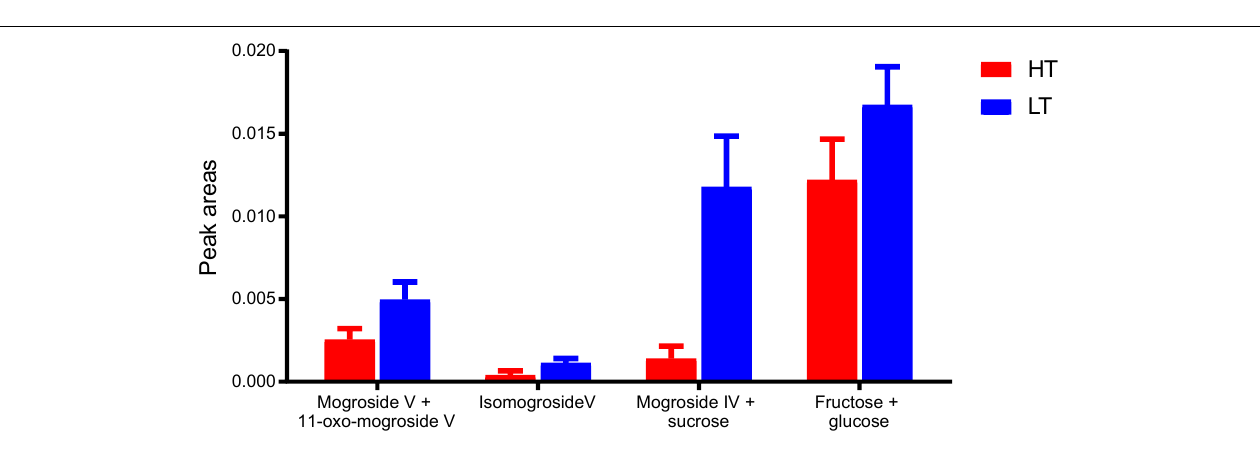
FIGURE 4 | Peak areas of selected mogrosides and sugars in HT and LT samples by HPTLC-scanning.